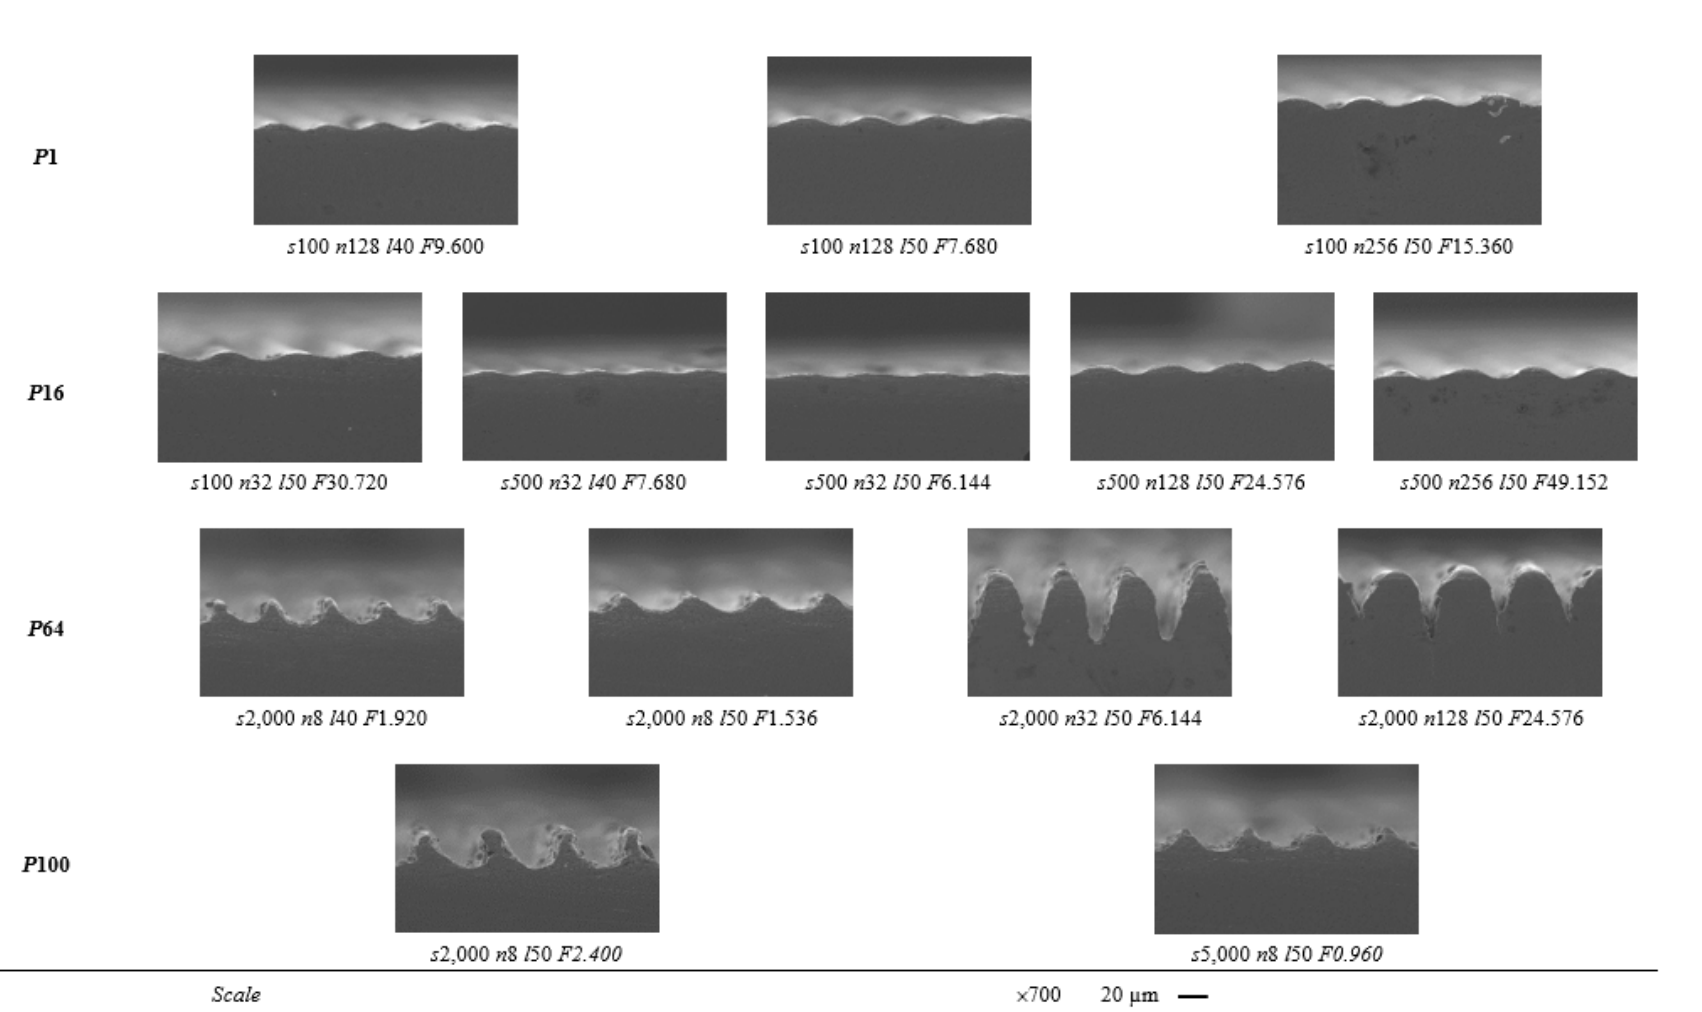
Figure 8. SEM images of the cross-sections of the fourteen samples with the most promising textures ( P = laser power in %, s = scanning speed in mm/s, n = number of passes, l = line spacing in µm, and F = laser energy fluence in J/mm 2 ).